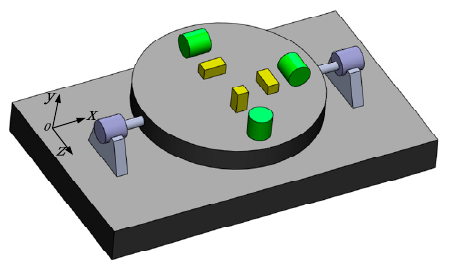
Figure 3. Concept of Isolation of the roll axis.